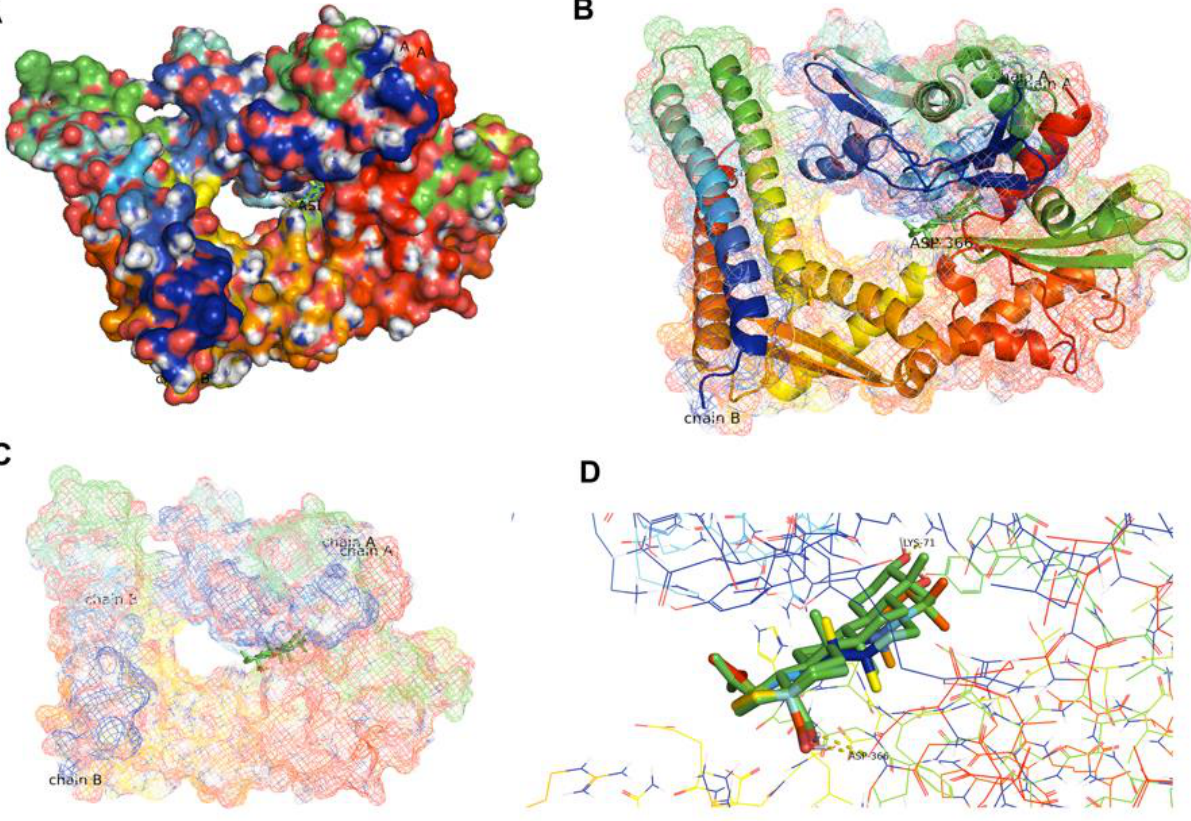
Figure 8. Docked structures of HSP70 (cid:48) s NBD in ADP-bound state (PDB ID 5AQF) ( A,B ) indicating the binding of BA to the ADP-binding region of HSP70 ( C ) with a close-up view ( D ).